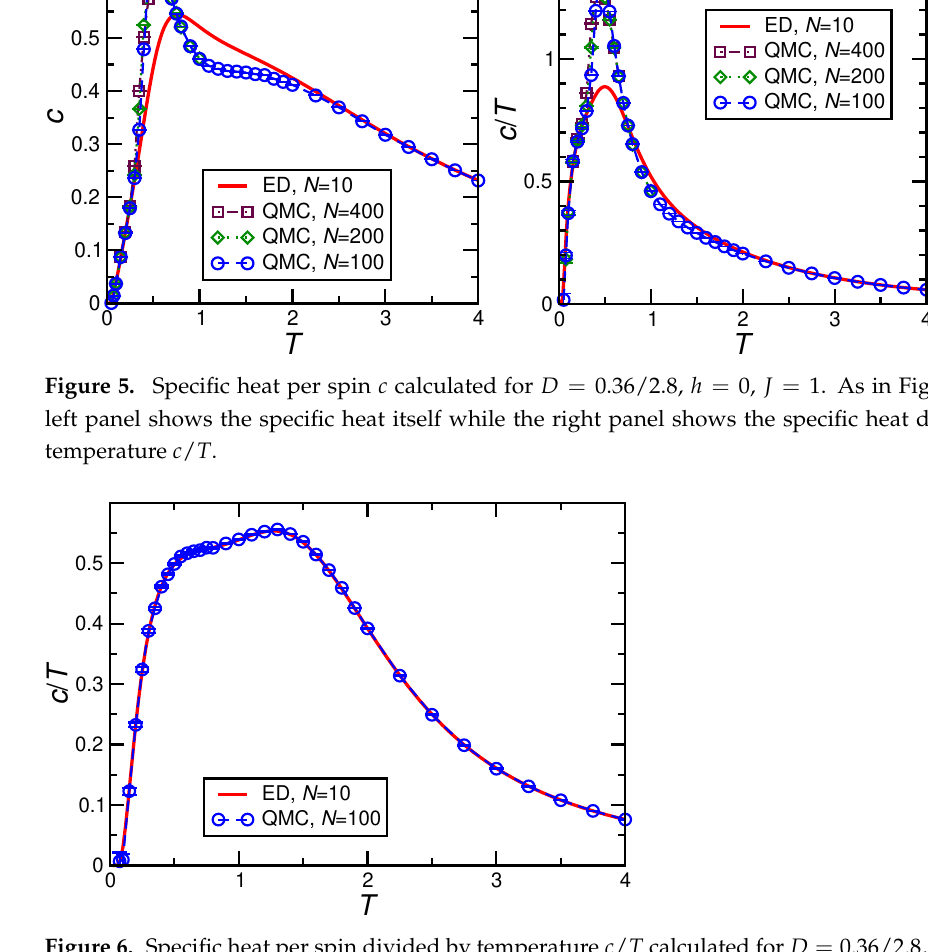
Figure 6. Specific heat per spin divided by temperature c / T calculated for D = 0.36/2.8, J = 1 in a magnetic field h =